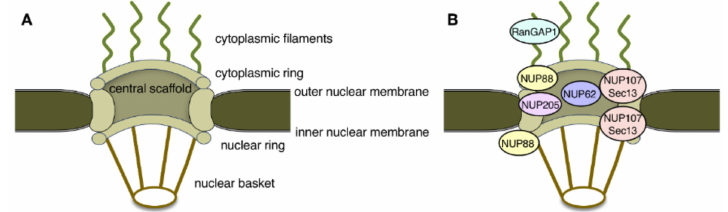
Figure 1. ( A ) Schematic representation of the main structural features of nuclear pore complexes (NPCs). ( B ) Localization of nucleoporins and nuclear pore associated factors implicated in neurodegenerative diseases within the 3D architecture of the